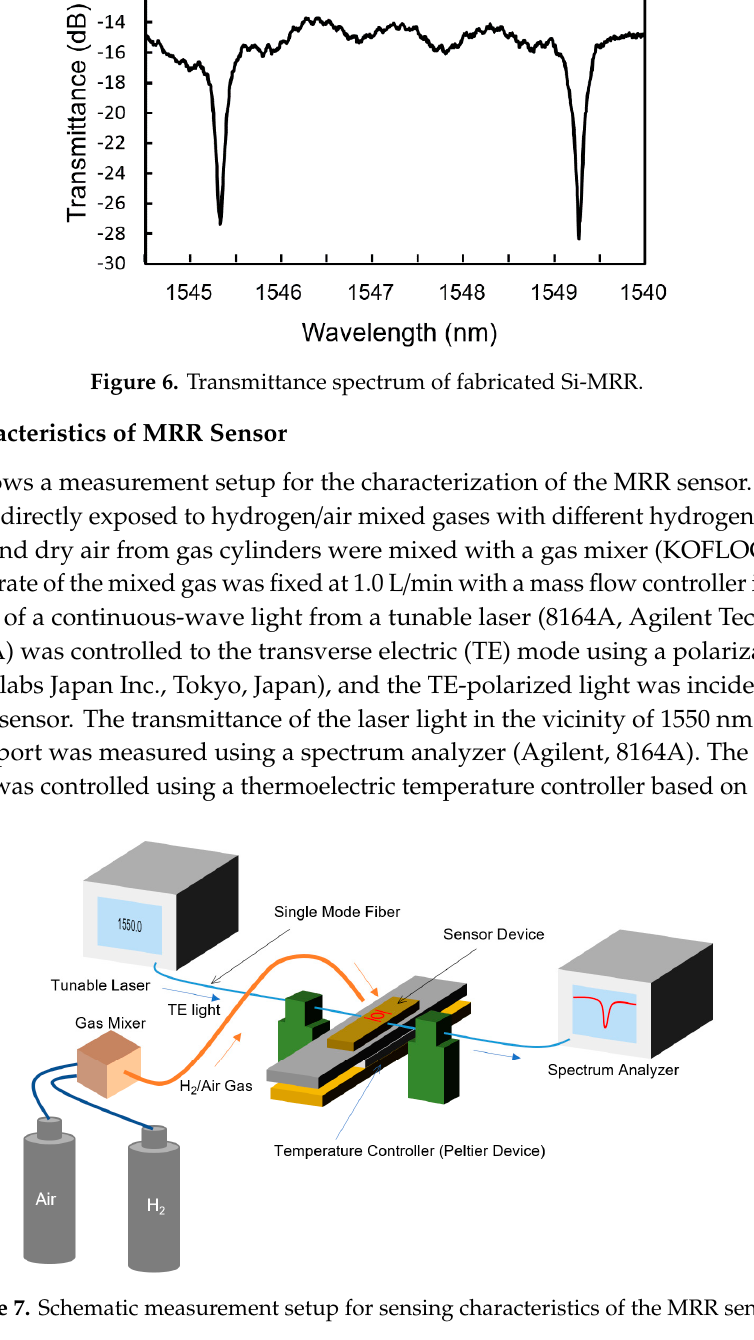
Figure 6. Transmittance spectrum of fabricated Si-MRR.